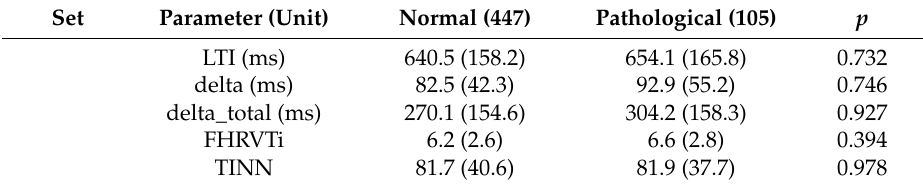
Table 4. Features extracted from the FHR signals for the normal and pathological groups (Set_3: Frequency domain; Set_4: Nonlinear). Key: Values are given as the mean (standard deviation). p